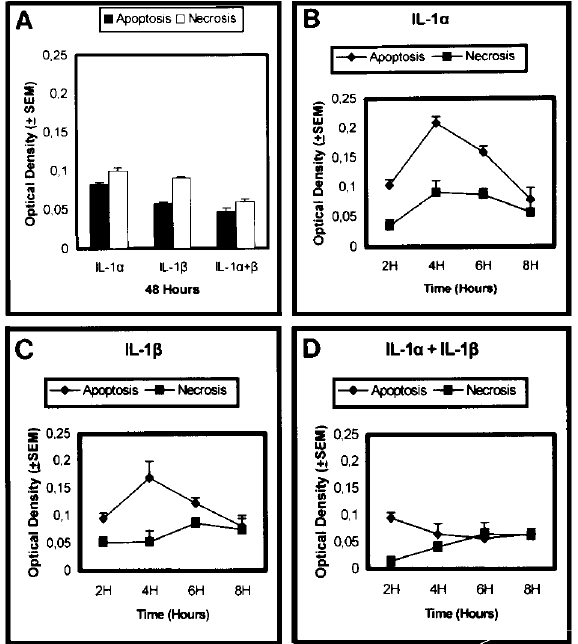
FIG. 1. Apoptosis vs necrosis on RIN-5AH cells after IL-1 exposure. (A) IL-1 a and IL-1 b after a 48-h treatment; (B) IL-1 a at earlier times; (C) IL-1 b at 2, 4, 6 and 8h; (D) Combination of IL-1